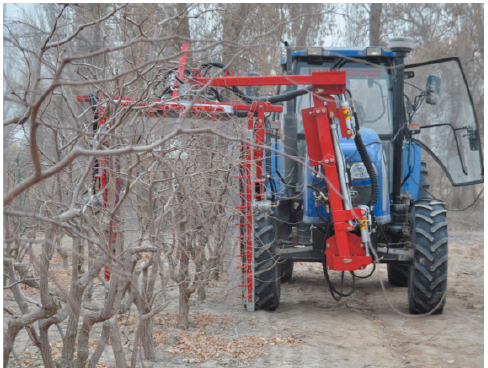
Figure 11. Performance test of shaping and pruning machine.